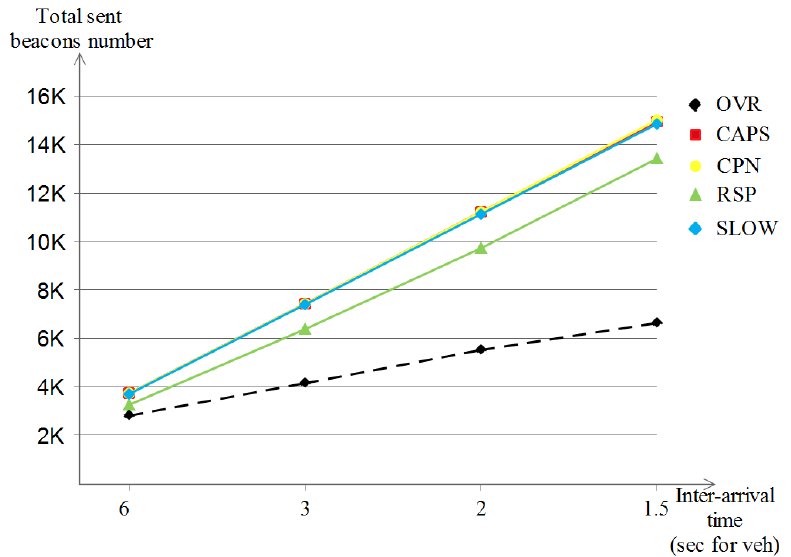
Figure 21. Sent beacons number of privacy schemes in the highway scenario.